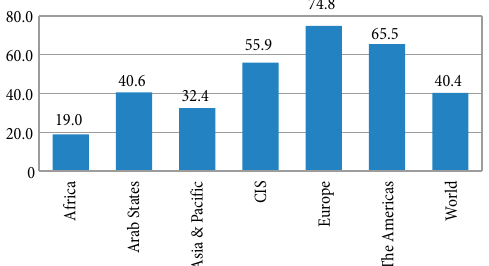
Fig. 1. Internet penetration rate (in millions) per 100 inhabitants (2014) Source : Internet World Stats (2014).